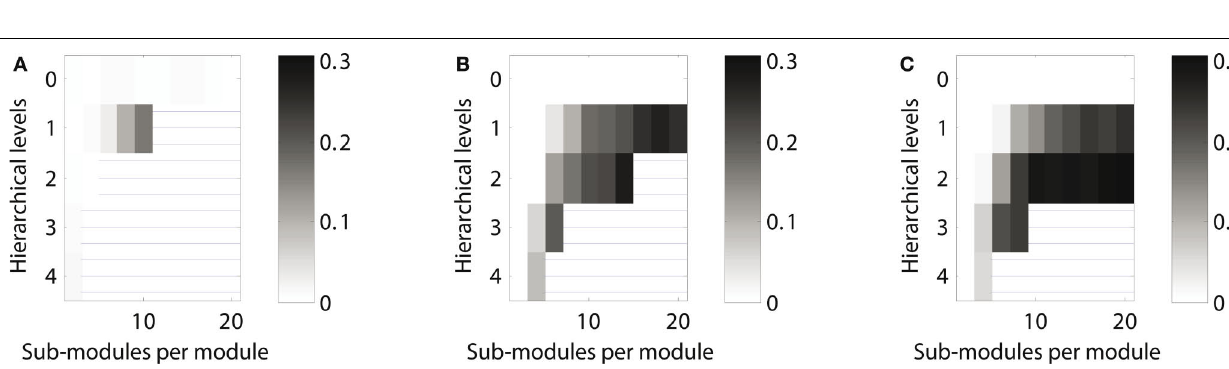
FIGURE 6 | Scaling of optimal confi gurations with network size for constant average node degree ( 〈 k 〉 = 50). Proportion of cases showing LSA (averaged over 200 networks generated for each confi guration) in (A) “rat-size” networks with 300 columns, (B) “cat-size” networks with 4,150 columns, and (C) “macaque-size” networks with 11,000